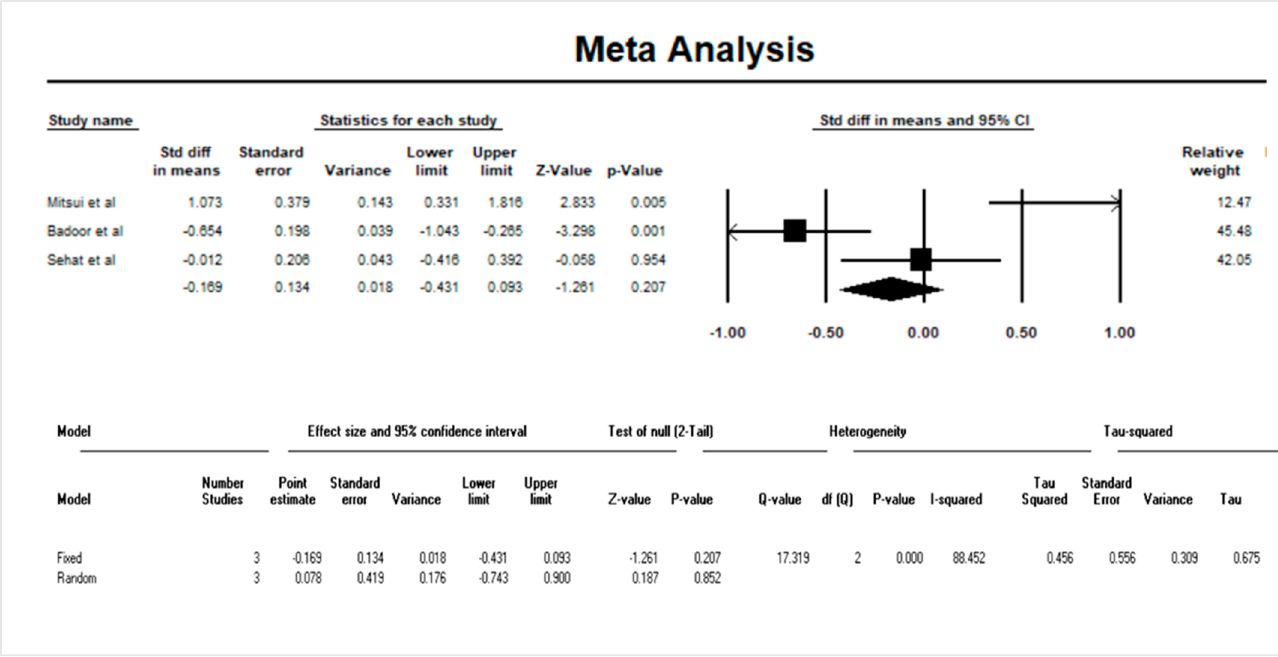
Figure A1. Sensitivity analysis [7–9].